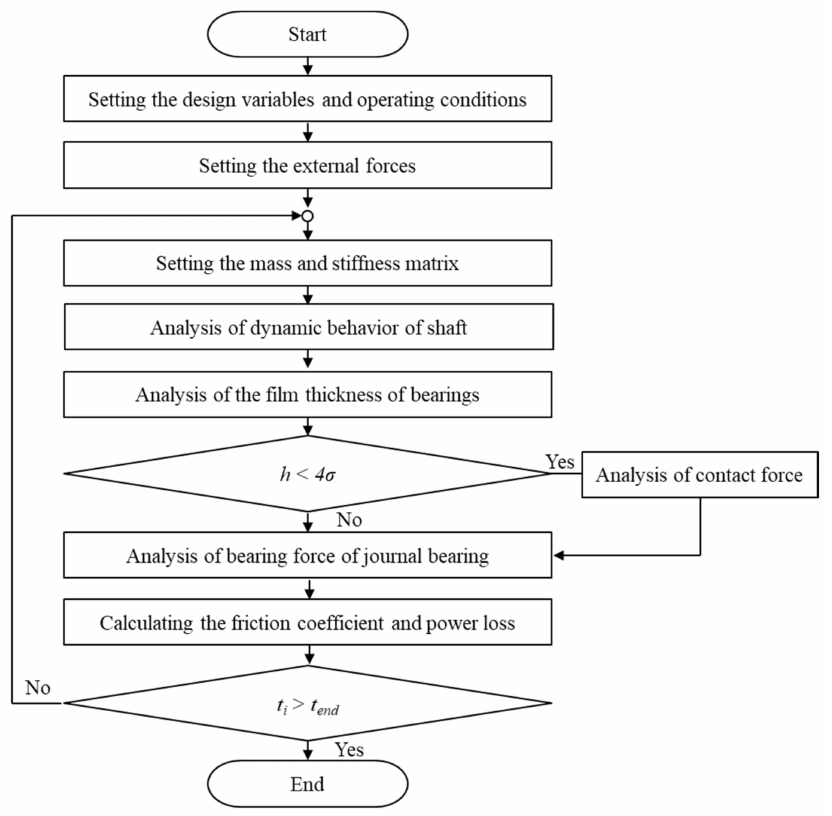
Figure 4. Analysis algorithm of friction coefficient and power